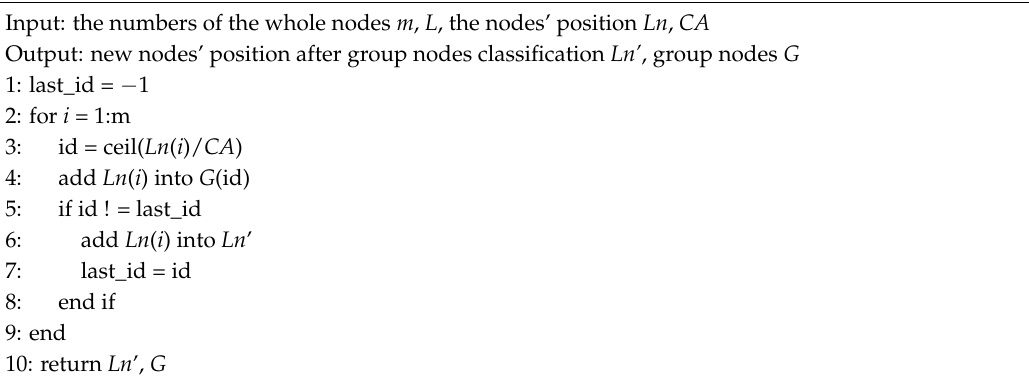
Algorithm 1. Partition of Group Nodes